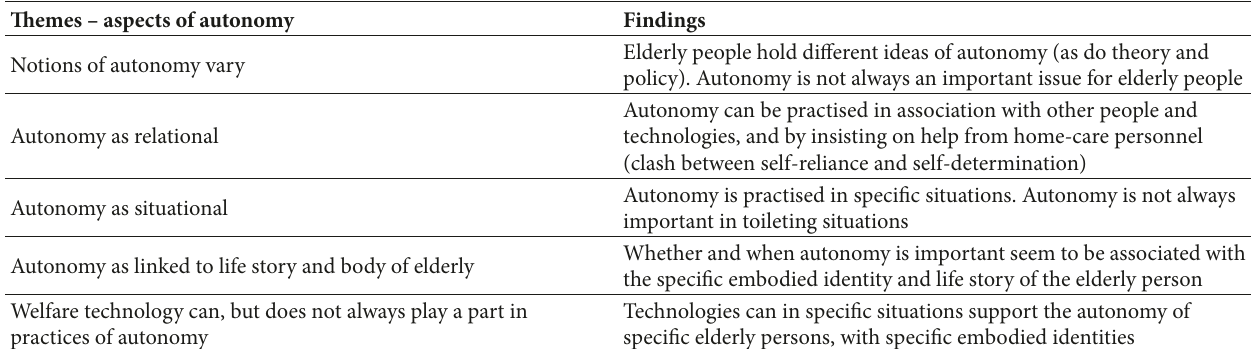
Table 2: Welfare technology, autonomy, and ageing bodies—themes and